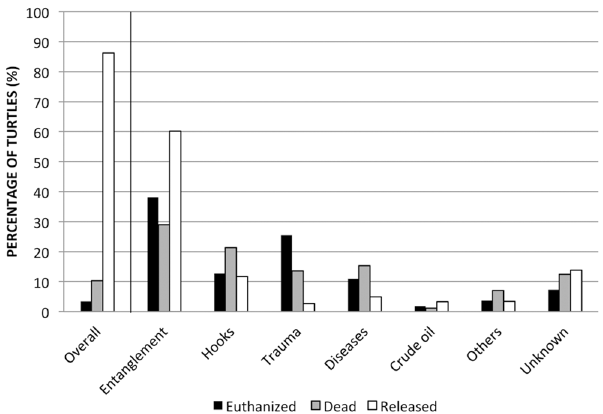
Fig 4. Resolution rates of euthanized (Er), dead (Mr), and released (Rr) loggerhead turtles relative to the overall population and the main cause of admission. doi:10.1371/journal.pone.0149398.g004 Time until death and length of stay at the TWRC Within the group of euthanized turtles the longest median T was observed for the unknown d = 85 days), whereas the shortest median T was recorded for the trauma category category (T d d (T = 1 day) (Table 3). The median T in the dead turtles ranged from 1.5 days (crude oil) to 8 d d days (entanglement, trauma, and other causes). Within the group of released turtles the median time of stay in the TWRC ranged from 12 days (unknown) to 70 days (trauma). Discussion Health status and anthropogenic threats of free-living sea turtle species are usually evaluated using as an important source of information the epidemiological studies of the causes of Table 3. Statistical descriptive of time that loggerheads spent in the TWRC until the final disposition. Time (days) from admission to fi nal disposition Euthanasia Unassisted